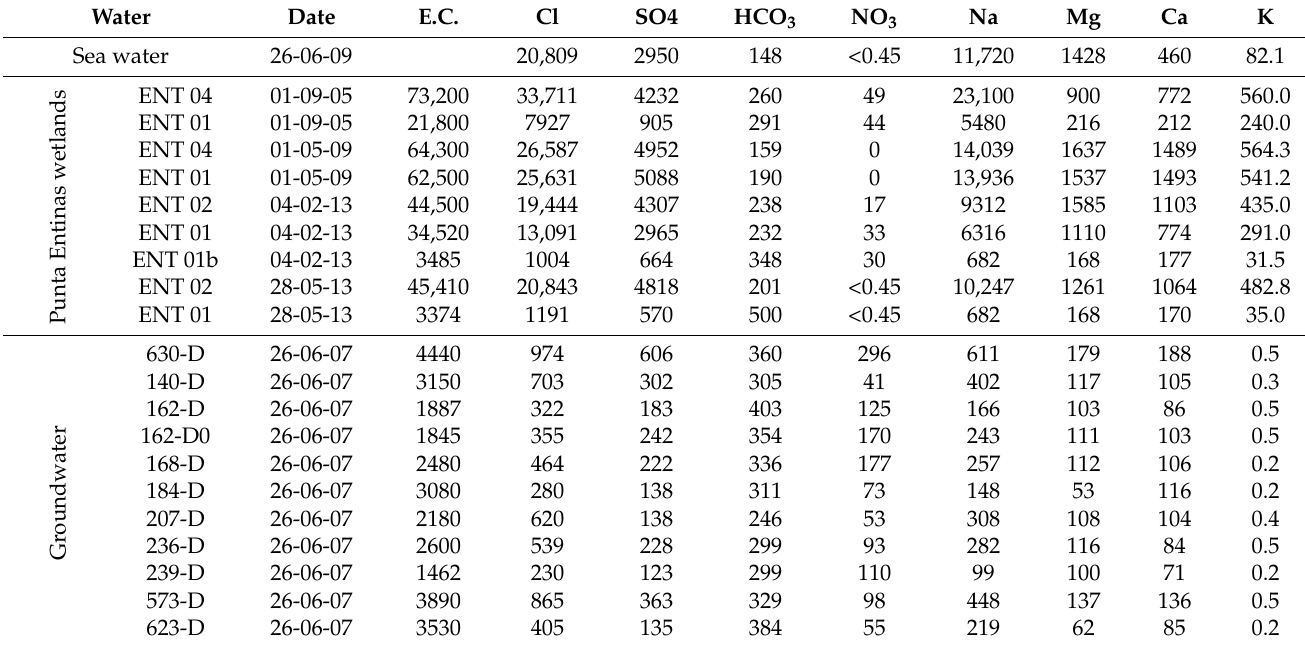
Table 1. Physico-chemical data of surface and groundwater. E.C.: electrical conductivity ( µ S · cm − 1 ), chemical concentrations in (mg/l).